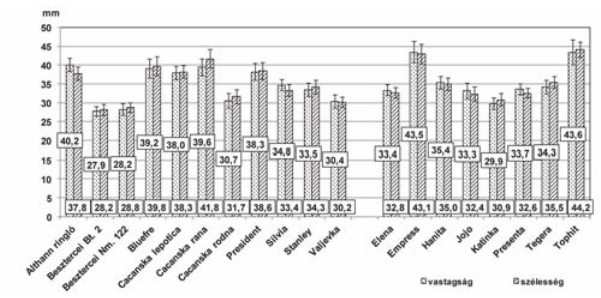
Figure 3 . Mean width and thickness of plum fruits with standard errors indicated